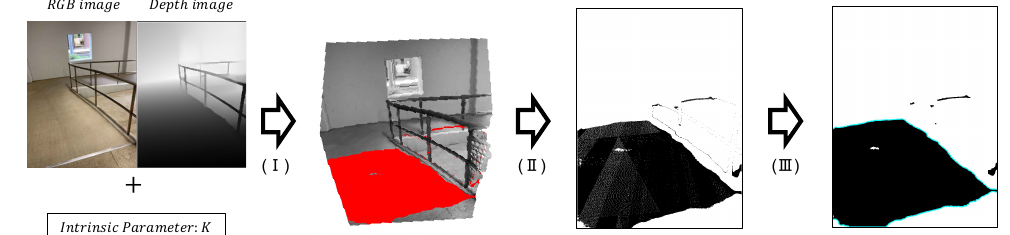
Figure 2. Flow of the initial difference-in-level detection method. ( I ) Create 3D point clouds from a RGB-D image. ( II ) The detected 3D plane is projected onto a 2D image using the intrinsic parameter, and then the image is binarized. ( III ) Detect the contour of the largest planar region after making the hole by morphological